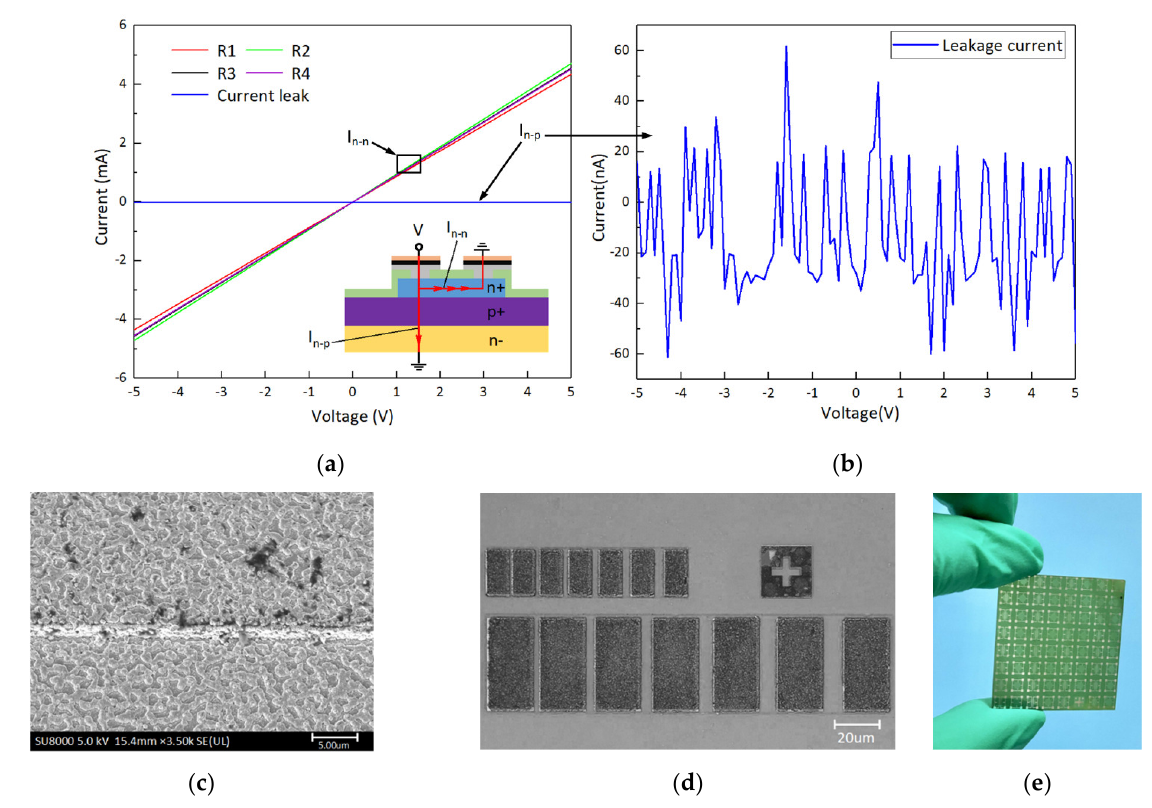
Figure 9. ( a ) Current–voltage characteristics of the piezoresistors in a sensor open loop Wheatstone bridge. Inset: Schematic diagram of the measurement of the current flowing in the n-type epitaxial 4H-SiC layer ( I n-n ) and through the p-n junction ( I n-p ). ( b ) Slight current leakage measurement. ( c ) SEM image of the metal surface morphology after annealing. ( d ) Linear transmission line model (LTLM) patterns for specific contact resistance (SCR) measurement. ( e ) Photograph of the 4H-SiC pressure sensor chips array. Table 3. Summary of results reported on specific contact resistivity of 4H-SiC Ohmic contact.